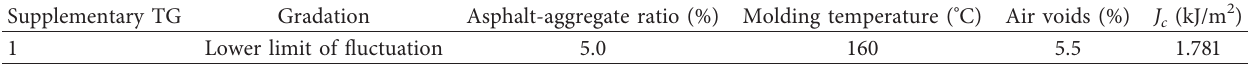
Table 13: Low temperature performance of supplementary